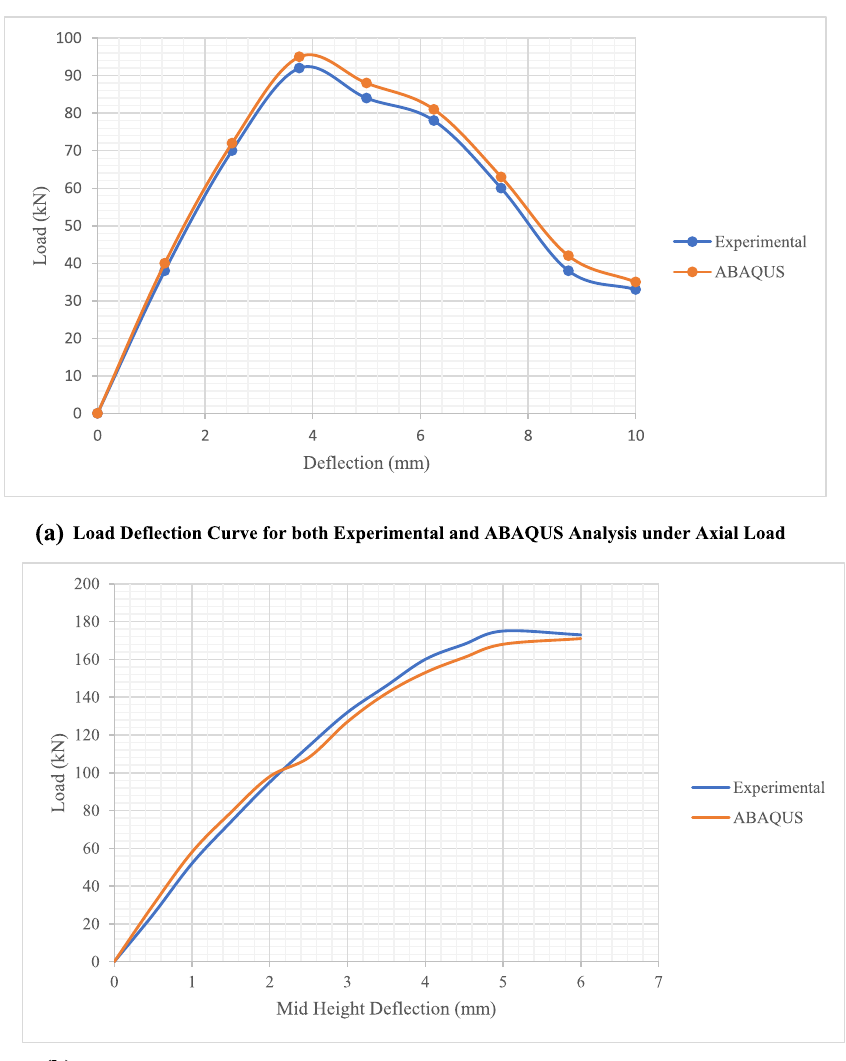
Fig. 5 Load displacement curve for both experimental and ABAQUS